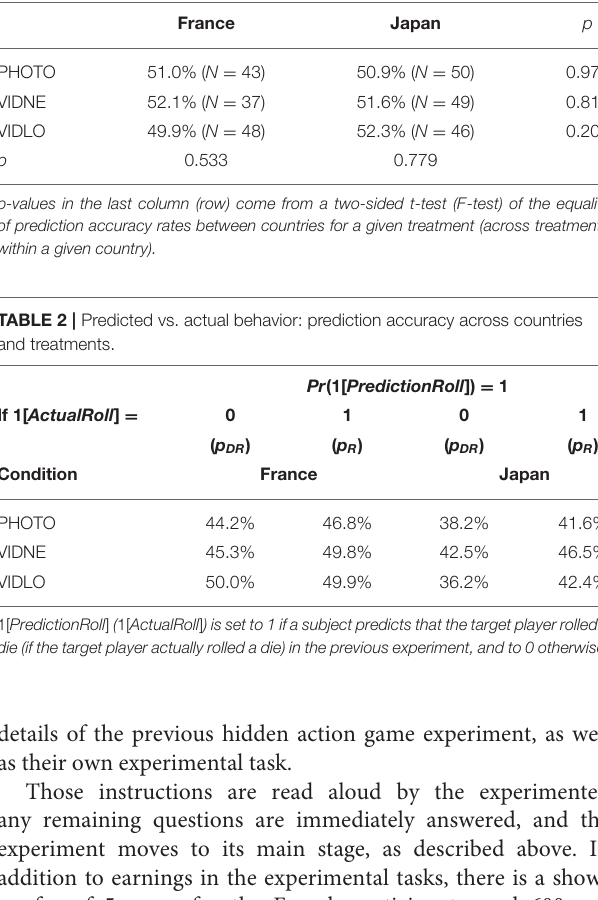
TABLE 1 | Average prediction accuracy rates across countries and treatments: aggregate data. France